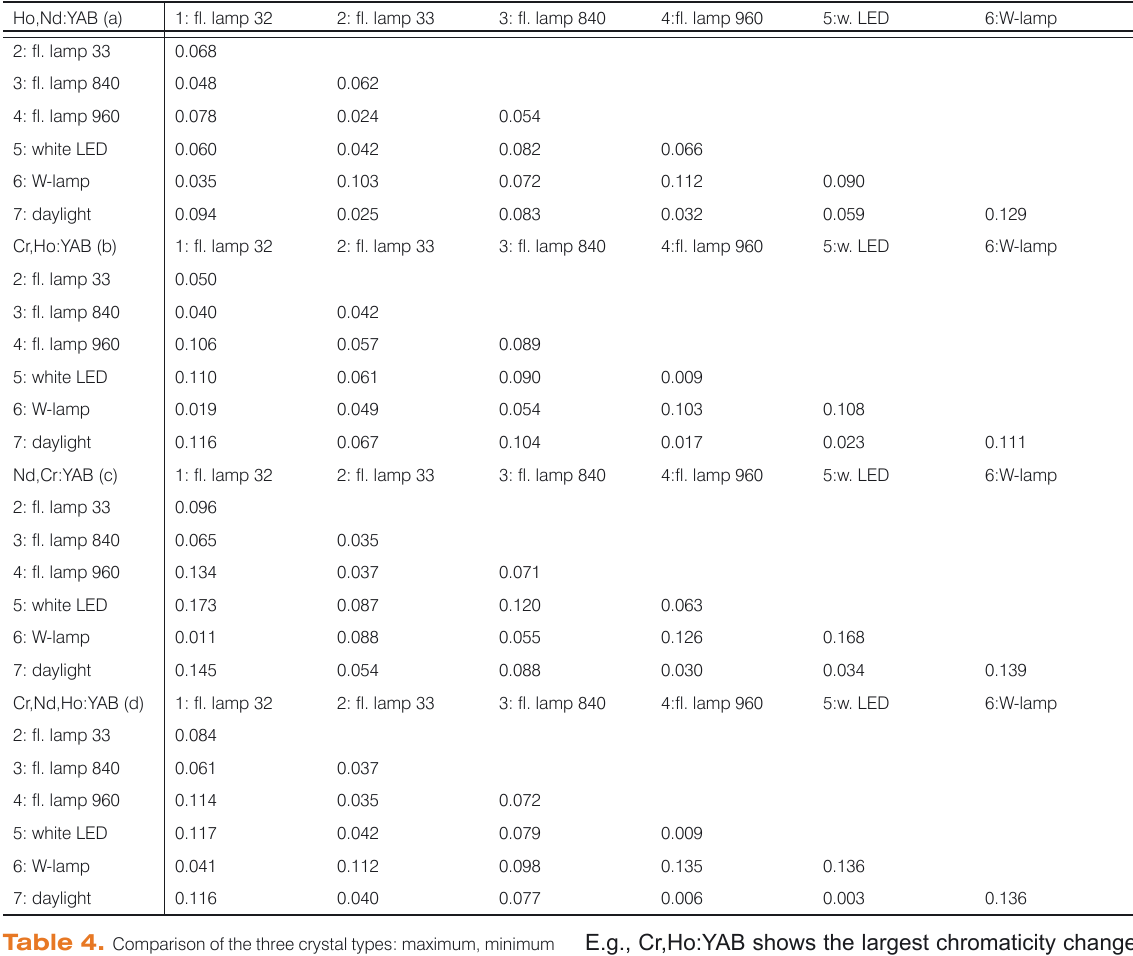
Table 3. Chromatic differences of the Ho,Nd:YAB; Ho,Cr,YAB; Nd,Cr:YAB and Ho,Nd,Cr:YAB crystals measured using CIE1931(xy) chromaticity co-ordinates.